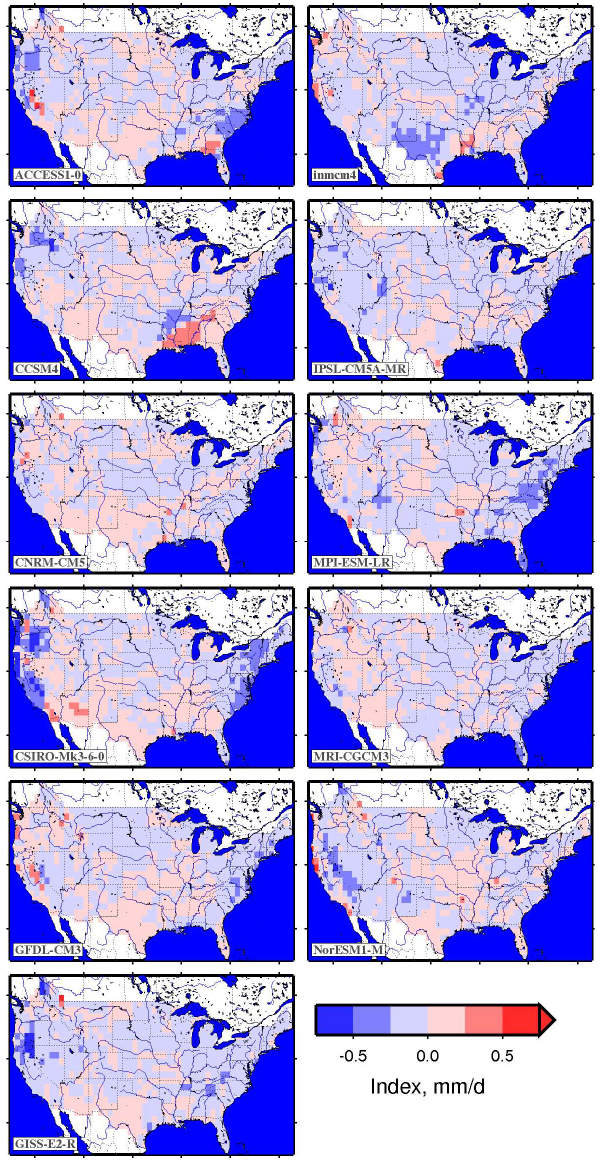
Fig. 8. For DJF, the TM index (described in the text) values for each